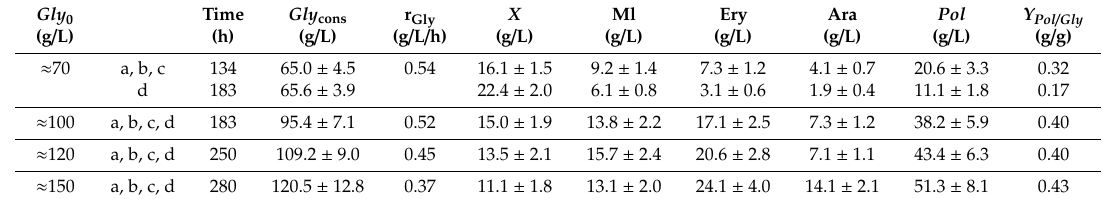
Table 1. Quantitative data of cultures of Yarrowia lipolytica LMBF Y-46 on glycerol-based media in which various initial glycerol concentrations ( Gly 0 ) were added with nitrogen being added to the medium as ammonium sulfate (2.0 g / L) and yeast extract (3.0 g / L). Culture conditions: growth